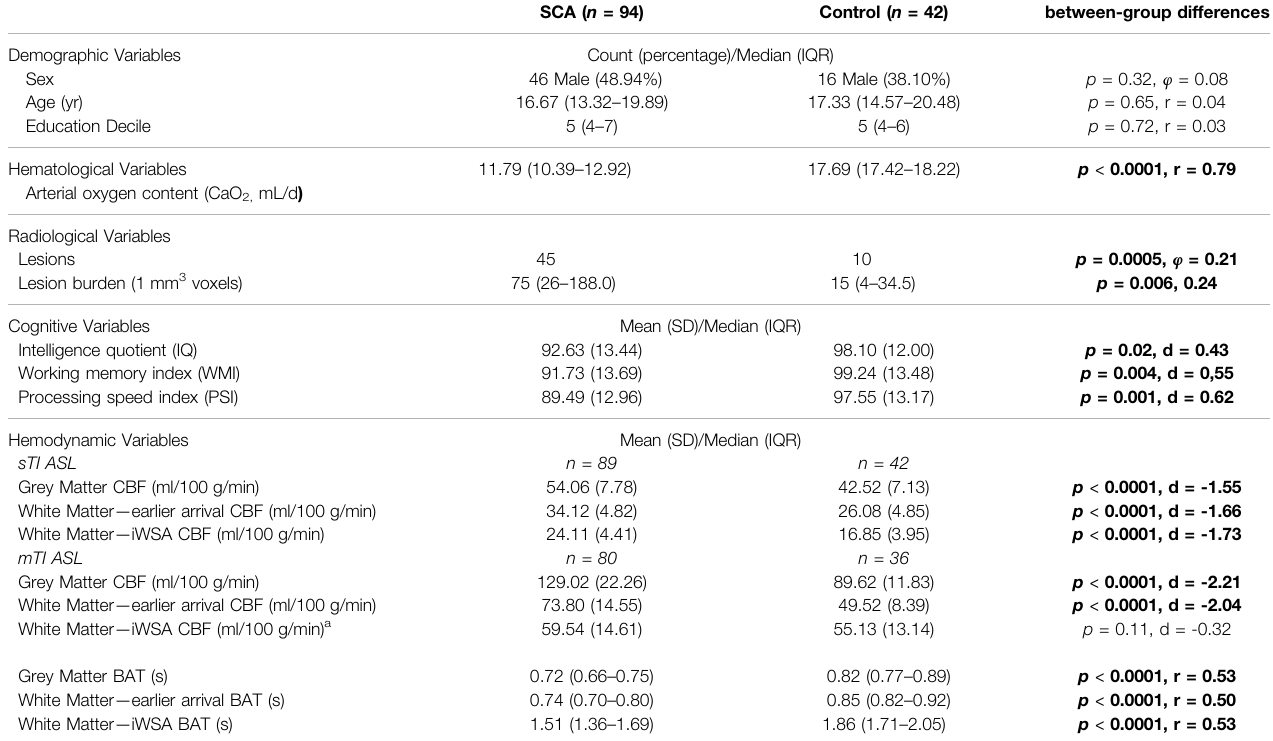
TABLE 1 | Sample demographics. Values are summary and test statistics for all included participants with usable single and/or multi in fl ow time ASL data. Abbreviations: SCA, sickle cell anemia; sTI, single in fl ow time sequence; mTI, multi in fl ow time sequence; CBF, cerebral blood fl ow; BAT, bolus arrival time; iWSA, individual watershed areas; SD, standard deviation; IQR, interquartile range; p, probability values for between-group differences. Signi fi cant between-group differences are shown in